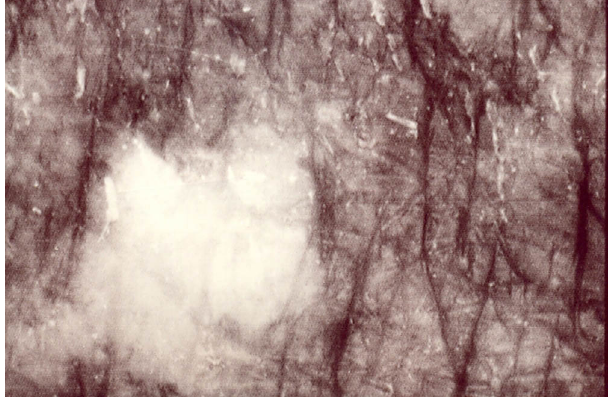
Figure 2. A women’s forehead. A sharply circumscribed medium-size